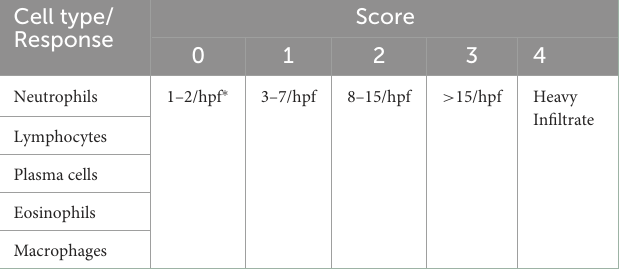
TABLE 3 Grading scales for scoring inflammatory cells in buffalo fly